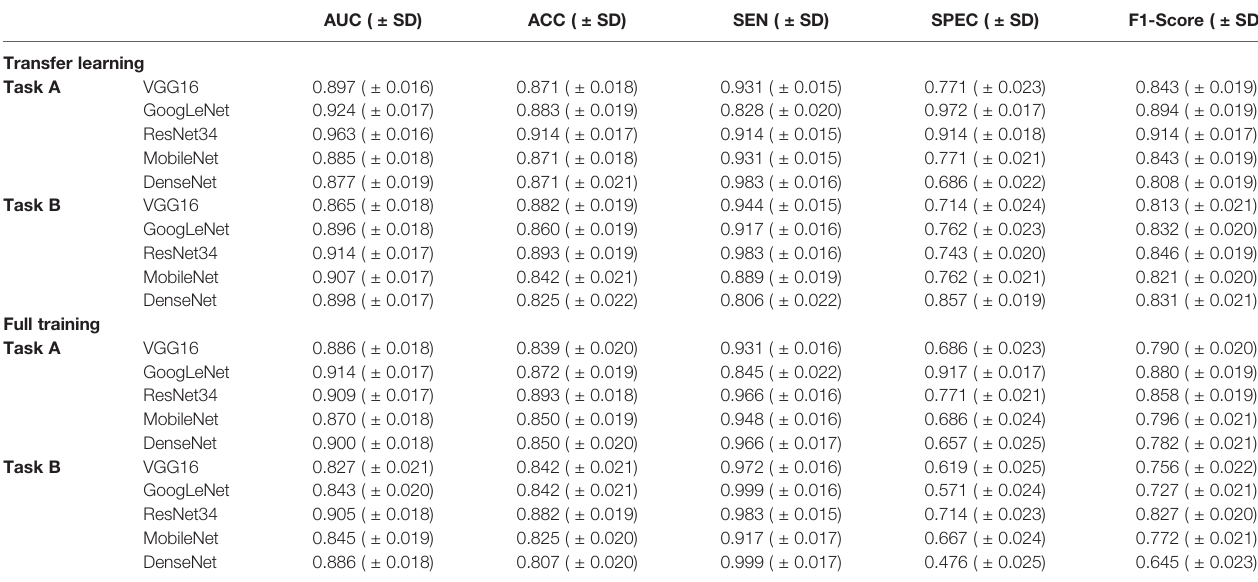
TABLE 1 | Performance of the two-class classi fi cation deep convolutional neural network models in the validation